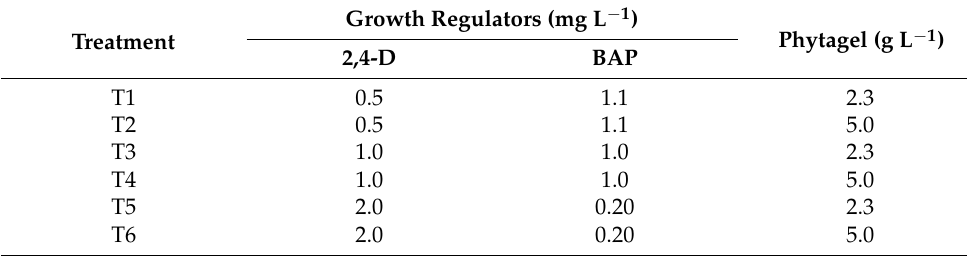
Table 5. Treatments used to induce the embryogenic calli from leaf explants of C. arabica var. Colombia.